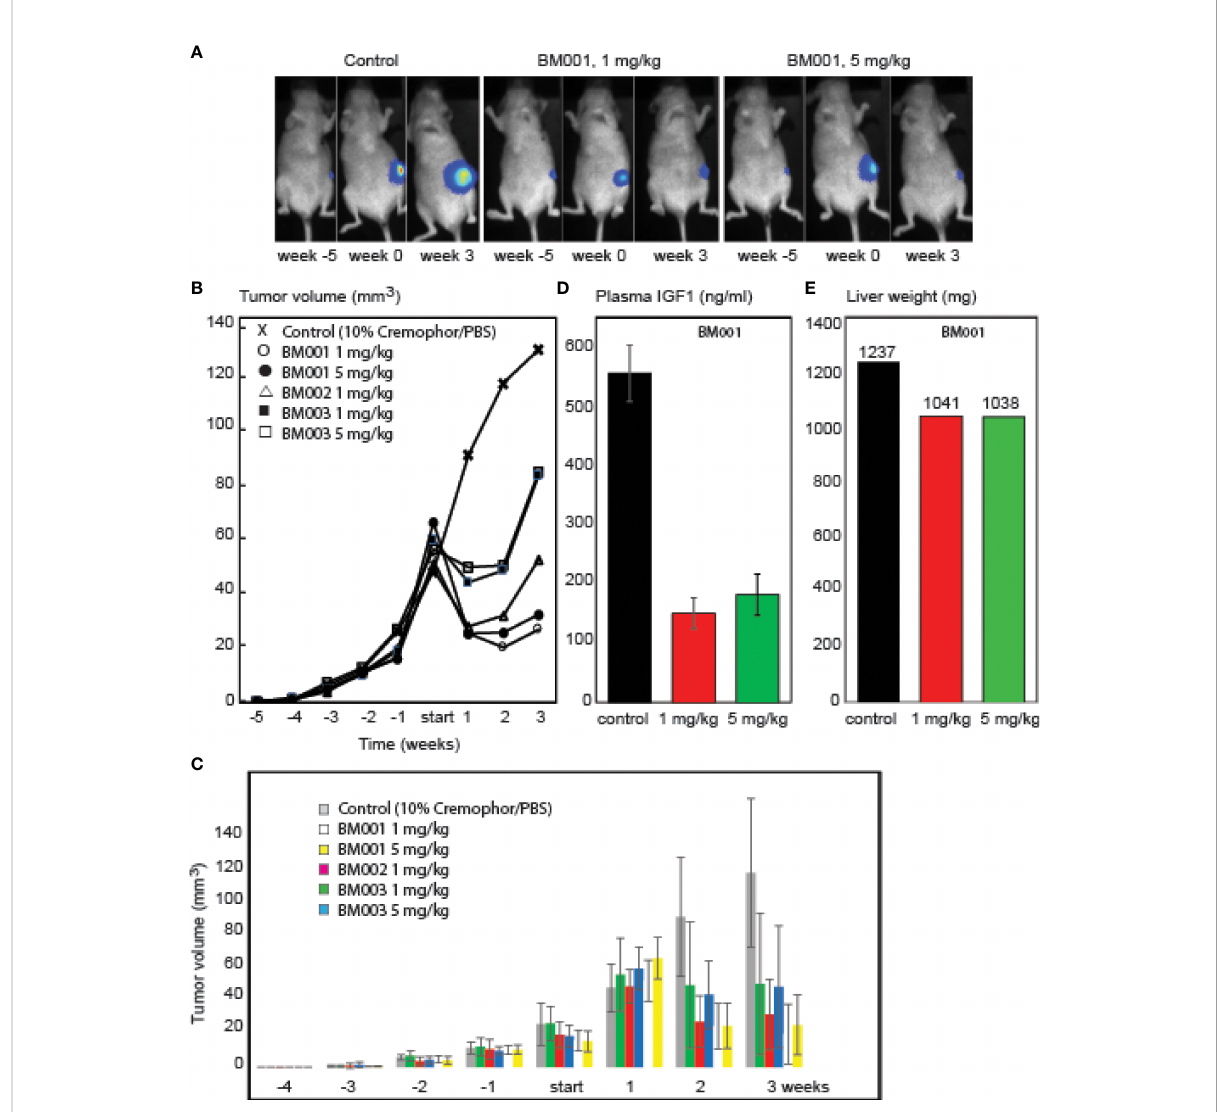
FIGURE 6 Effect of the identi fi ed GHR drugs on breast cancer growth in mice. A. Compounds BM001, BM002 and BM003 inhibit tumor growth. Bioluminescence imaging was used to visualize tumor growth over time (A) and tumor volumes were longitudinally measured in response to the indicated BM compounds (B, C) . BM001 treatment results in a dose-dependent reduction in plasma IGF1 levels (D) and liver weight (E) . Statistical analysis was performed with GraphPad Prism 8.0 (San Diego, CA, USA). Data is presented as mean